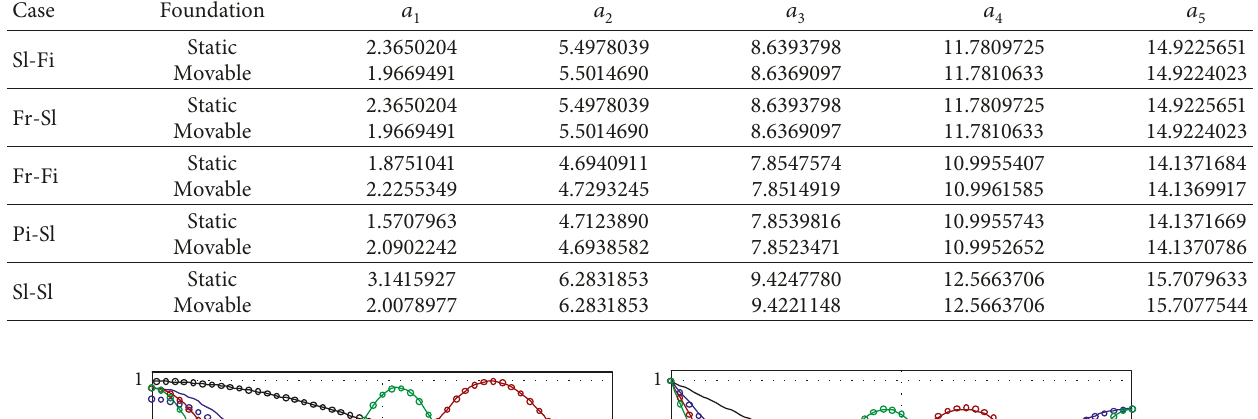
2 √ ) for five degenerate cases with a static or a movable Winkler